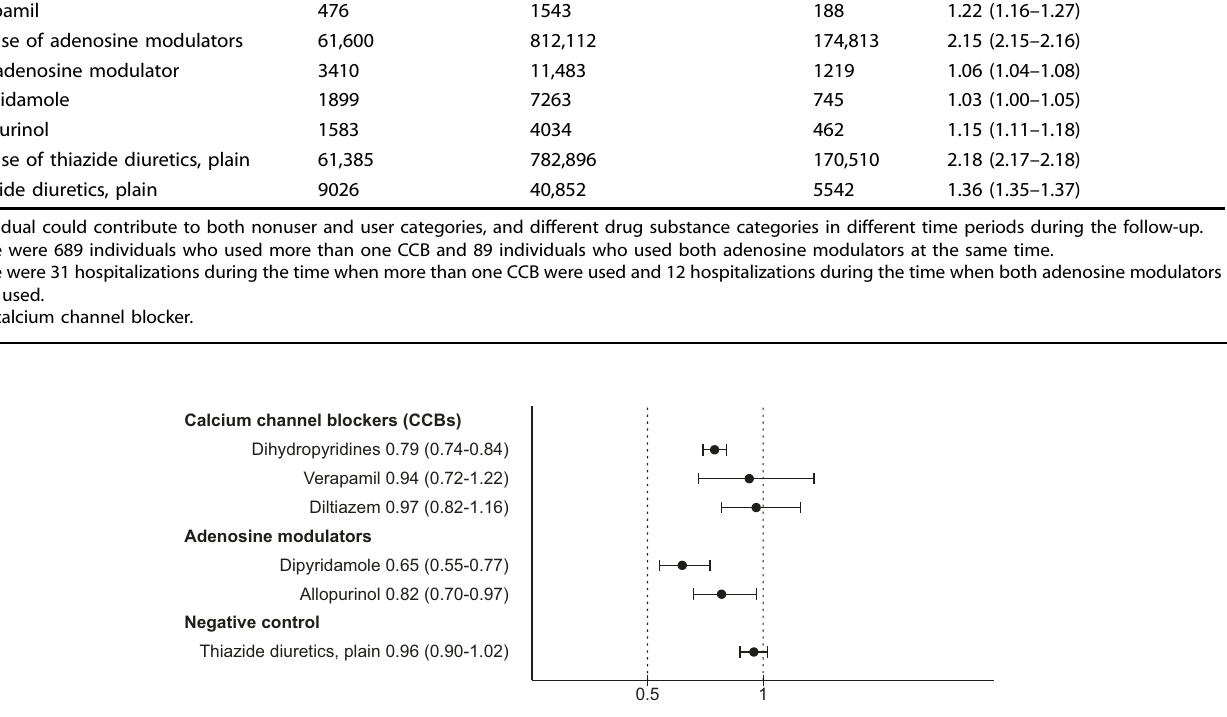
Fig. 1 Risk of psychiatric rehospitalization associated with add-on drug use compared with nonuse of add-on drug, within-individual model. Hazard ratios with 95% con fi dence intervals.